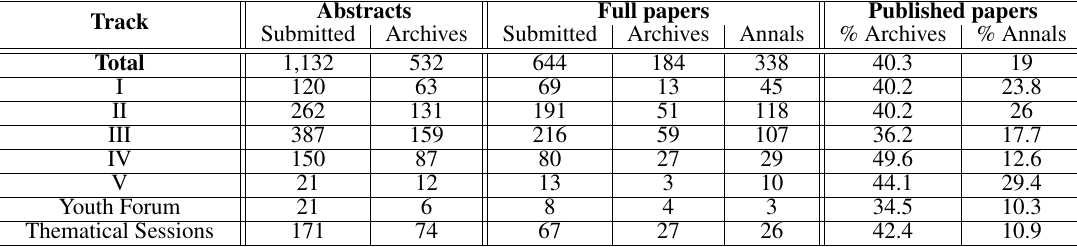
Table 2. Detailed statistics for each track.